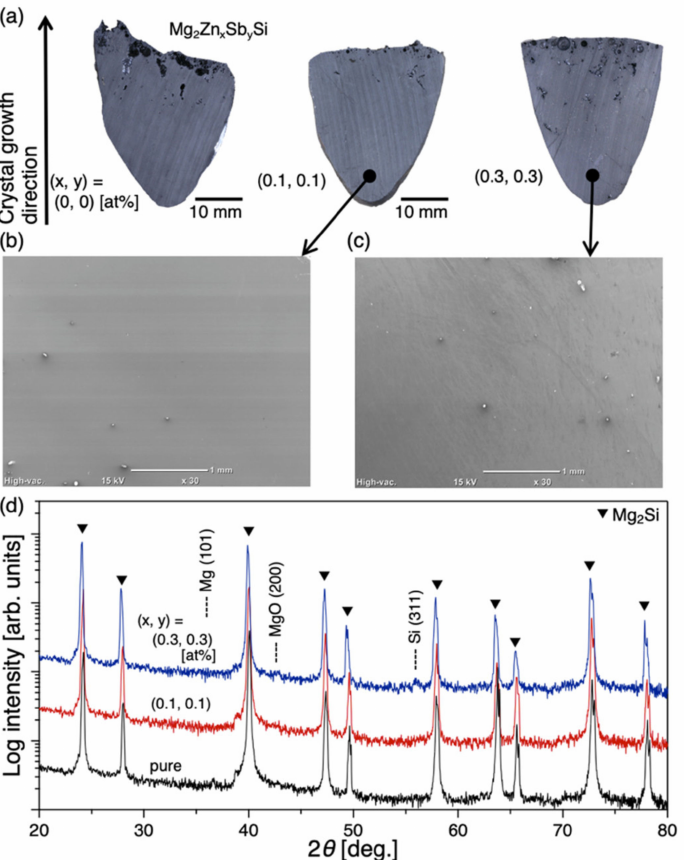
Figure 3. ( a ) Cross-sectional photographs, ( b , c ) SEM images, and ( d ) powder XRD patterns of VB- grown Mg 2 Zn x Sb y Si. (Reprinted by permission from Springer Nature: Springer, Journal of Electronic Materials , “Enhanced thermoelectric performance of vertical Bridgman-grown Mg 2 Si by codoping with Sb and Zn”, D. Shiojiri, T. Iida, H. Hamba, T. Kodama, M. Yamaguchi, N. Hirayama. and Y. Imai, Copyright